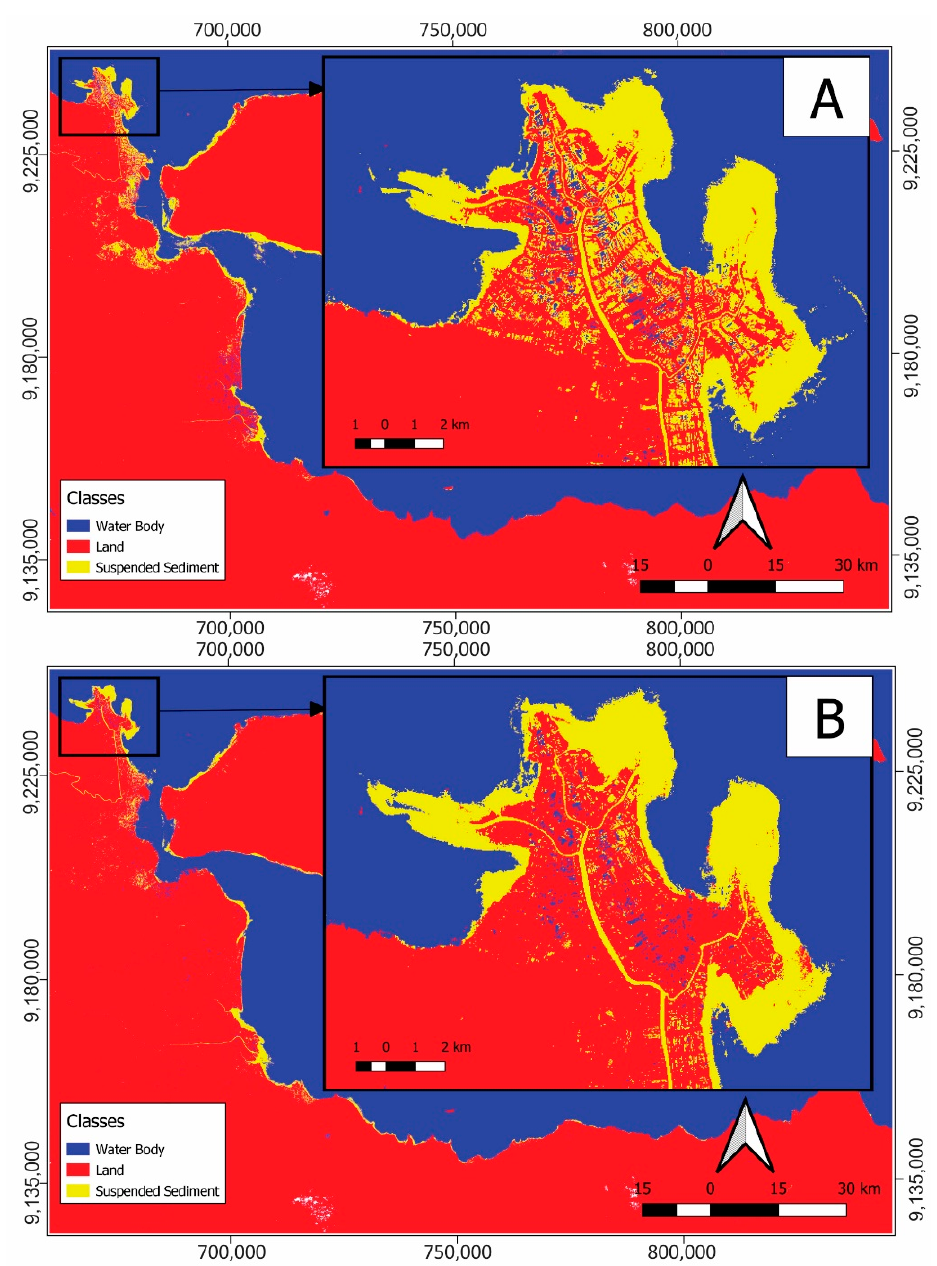
Figure 4. Classification of land and water bodies (seawater in blue, turbid water in yellow) in the year 2000 by ( A ) RF with 80 trees (OA: 84%) and ( B ) GMO-Maxent (OA: 93.6%), revealing the misclassification of land areas as turbid water (inset).